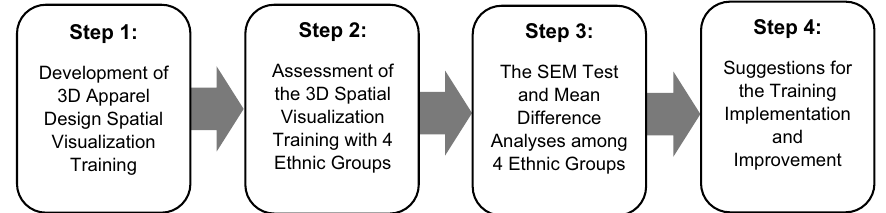
Fig. 2 Research process of this study. SEM structure equation